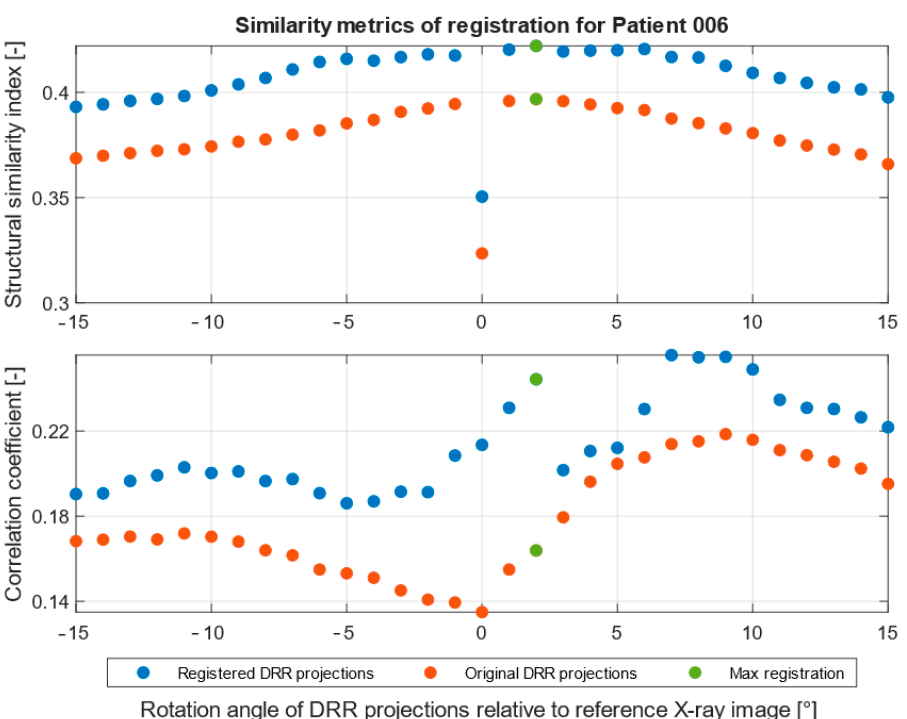
Figure 10. Similarity metrics of image registration of 30° angle range for Patient 1. DRR projection with the highest similarity is marked as green.